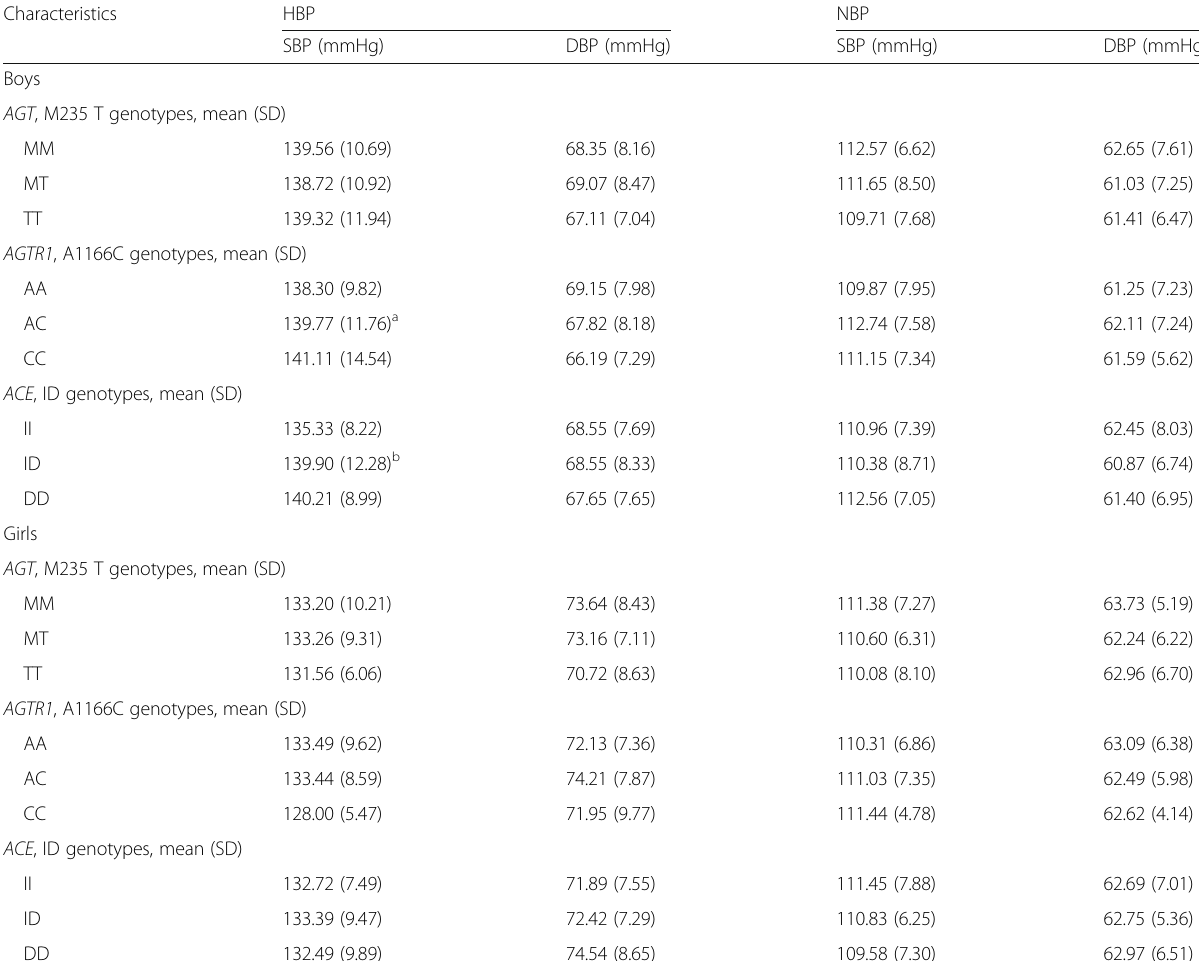
Table 3 Distribution of AGT M235 T, AGTR1 A1166C, and ACE ID genotypes according to systolic and diastolic blood pressure in the study population